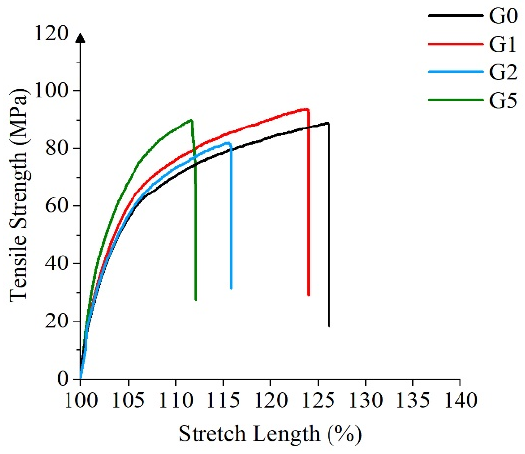
Figure 11. Mechanical strength.